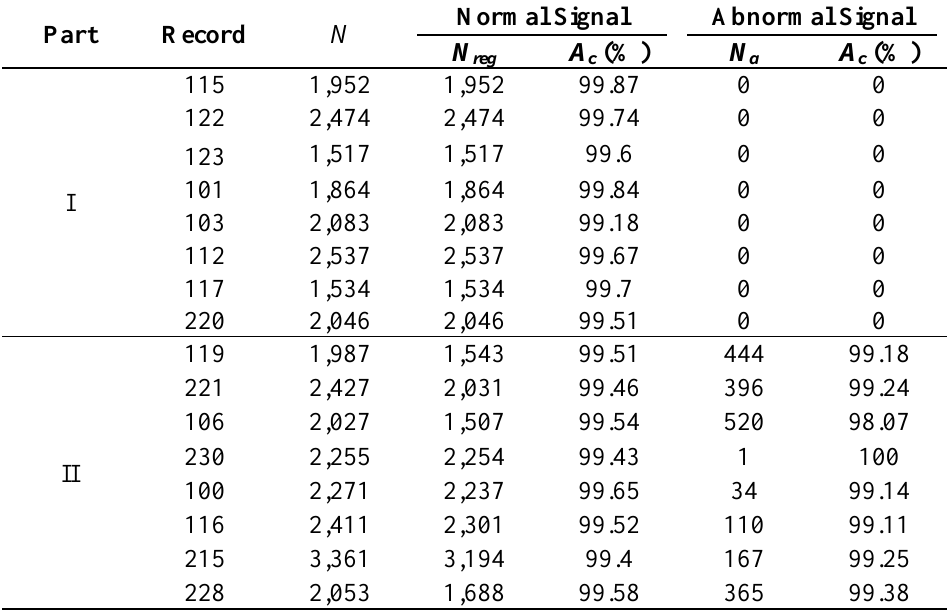
Table 2. Performance of ECG signal feature extraction method based on HMM.